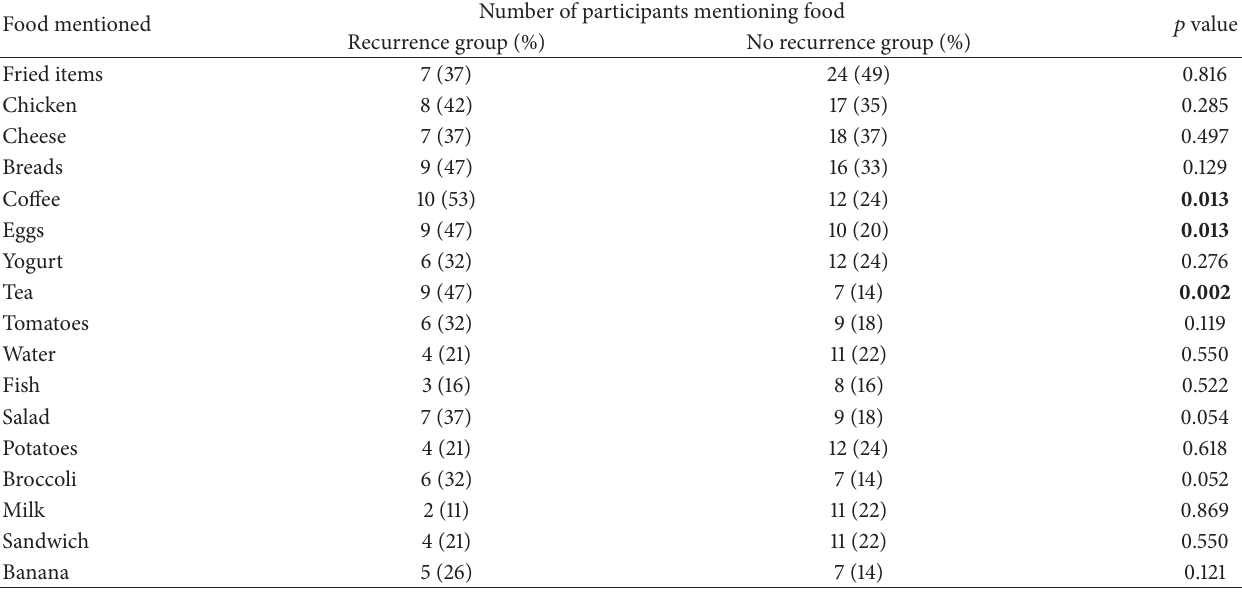
Table 2: Foods mentioned in 24-hour recall listed by